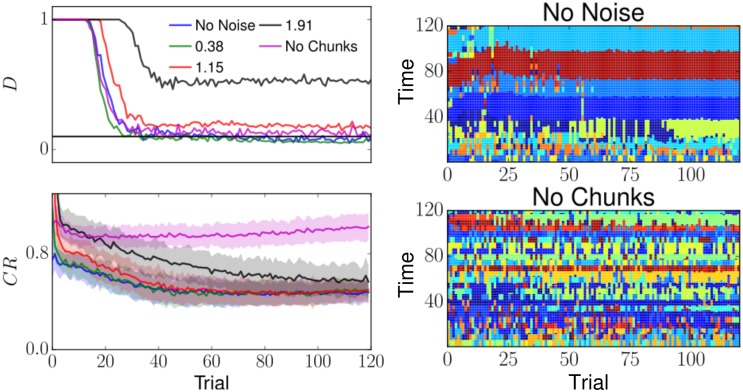
The dynamics of chunking.The model is run 60 times, for 120 trials (N
y = 30) for different levels of noise. Each trial consisted of the presentation of one sequence, followed by a recall phase. (Top-Left) Sequence recall accuracy D averaged over all the runs. The sequence was determined by the identity of the most active mode in the elementary layer.D was computed using the Levenshtein distance (equal to the number of additions and subtractions between two sequences). In the noiseless and low noise cases, the distance between the presented sequence and the reproduced sequence reached about.05 (horizontal line), roughly corresponding to 1 addition/subtraction per sequence recall. The network was robust to noise, and sequence recall accuracy degraded gracefully as the amplitude of noise was increased. (Bottom-Left) Estimates of chunking rate measure CR for monitoring chunking in the noiseless case (blue curves).CR is defined as the number of transitions taking place in the chunking layer during the presentation of a pattern in the sequence. During an initial transient CR decreases as learning proceeds, indicating the formation of the chunks. (Right) Activity in the chunking layer for two representative runs, one with no noise, the other with no chunks, where learning of Q
ij and R
ji was turned off. The identity of the chunks is color-coded. Interestingly, the boundaries of the chunks can change during training, and the chunks can undergo substantial reconfigurations at the beginning of the training phase. In absence of learning in Q
ij and R
ji, the chunking rate did not diminish over the course of learning, indicating the absence of chunks. S4 Fig displays the evolution of the individual weights for the run shown in the top-right panel (No Noise).